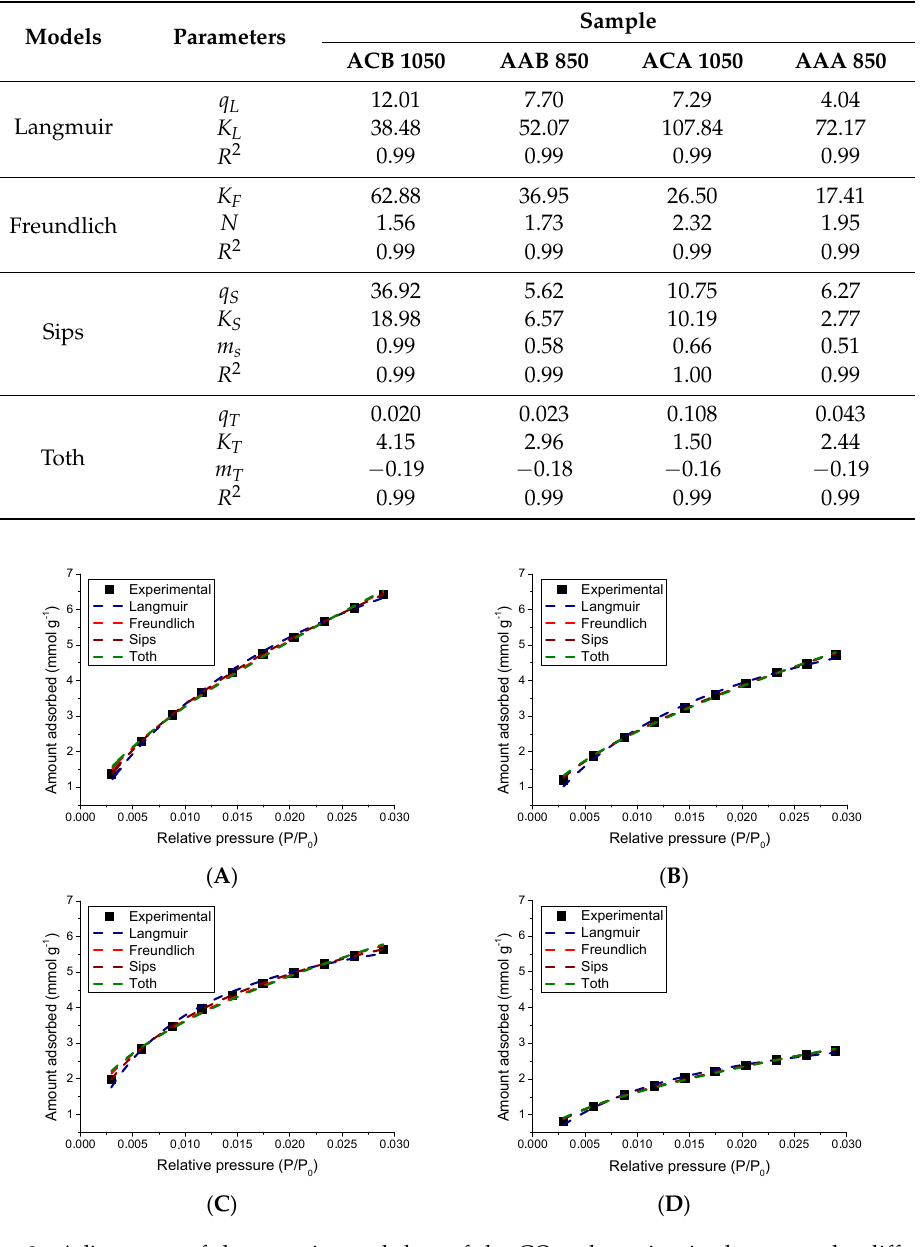
Figure 9. Adjustment of the experimental data of the CO 2 adsorption isotherms to the different theoretical models in the samples: ( A ) ACB 1050; ( B ) AAB 850; ( C ) ACA 1050 and ( D ) AAA 850.